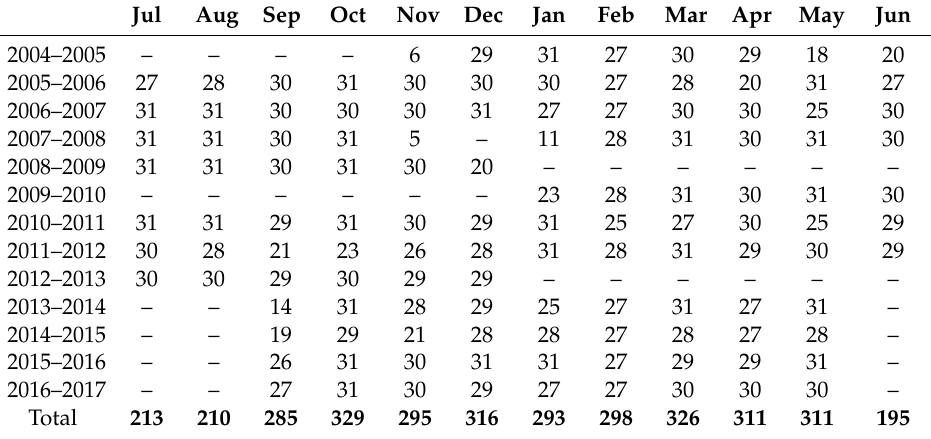
Table 1. Monthly number of nights of radar observations from the Bourke Insect Monitoring Radar (IMR) in each insect-flight season from November 2004 to May 2017. Each radar file has observations for the 12 hours from 18:00 to 06:00 h